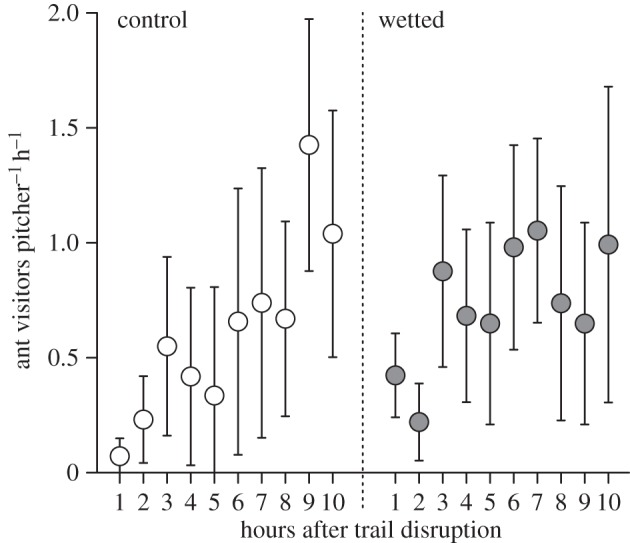
Discovery of and recruitment to natural (control) and constantly wetted pitchers by ants, observed with a time lapse camera (1 frame per 5 min) over a period of 10 h. The circles represent visitor numbers per hour (geometric means) and the whiskers denote ±1 s.e. Despite the high variability of ant visits between pitchers, a significant upward trend of hourly visitor numbers could be observed for control but not for wetted pitchers.